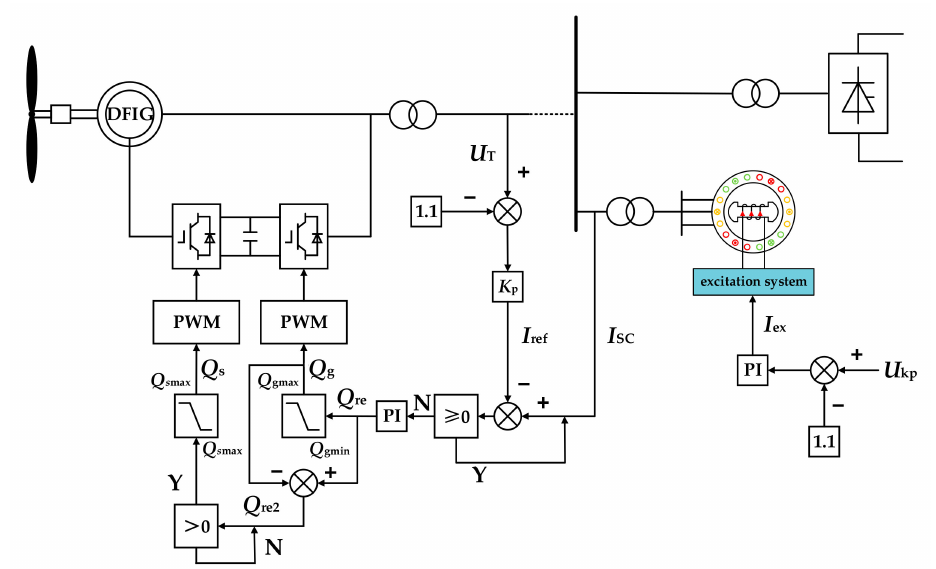
Figure 12. The coordinated control of the DFIG and synchronous